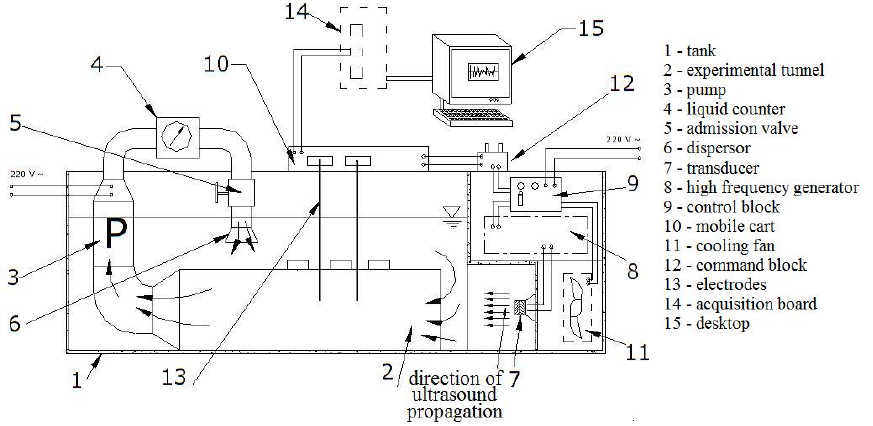
Figure 1. Experimental plant for the cavitation study [39].